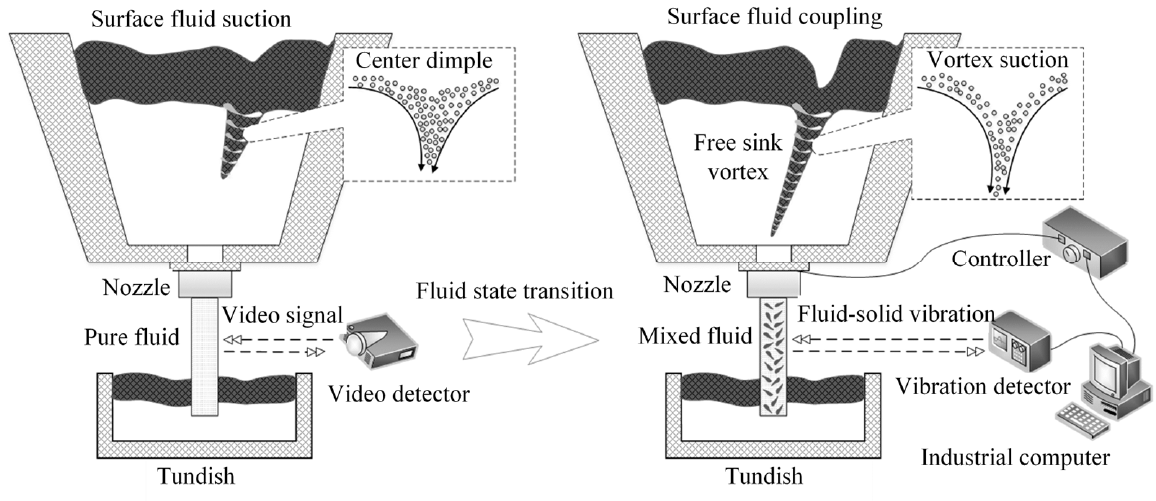
Figure 2. Basic principle of the vibration detection method.